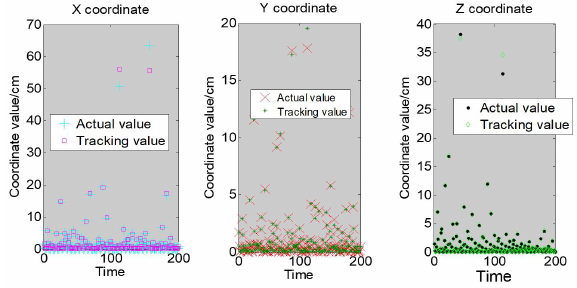
Fig. 9. Error analysis of the two tracking algorithms on the Fig. 8. Comparison result of fingertip tracking value and indoor complex background test set real value